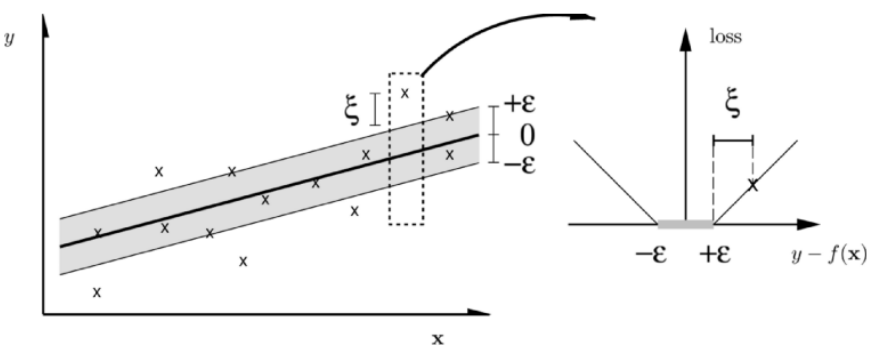
Figure 2. SVR algorithm fitting a tube of radius ‘ ɛ ’ to the data [47].